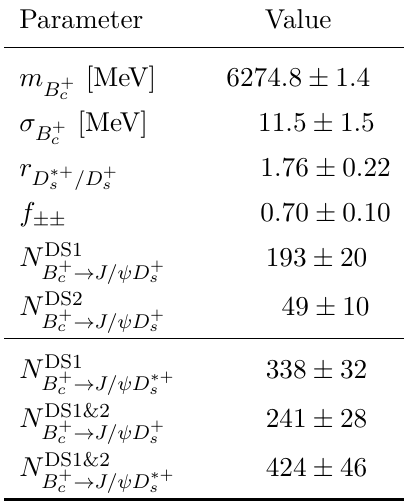
and B + signals obtained with the unbinned → J/ψD + → J/ψD ∗ + c s c s